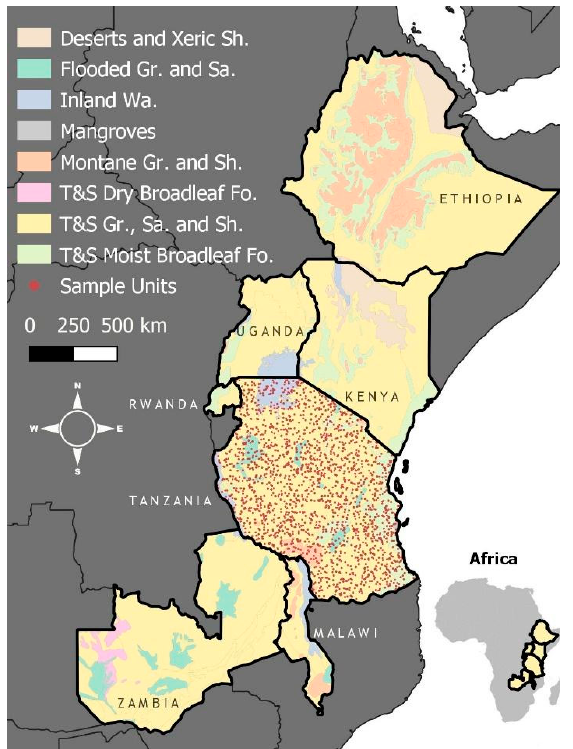
Figure 1. The ecoregions of the seven-country study region in East Africa. The 2000 randomly selected sample units are shown for Tanzania, however the same sampling routine was performed in each country. Sh, Shrublands; Gr, Grasslands; Sa, Savannas; Fo, Forests; T&S, Tropical and Subtropical. Land covers are defined by ecoregion categorization in Olson et al. (2001).